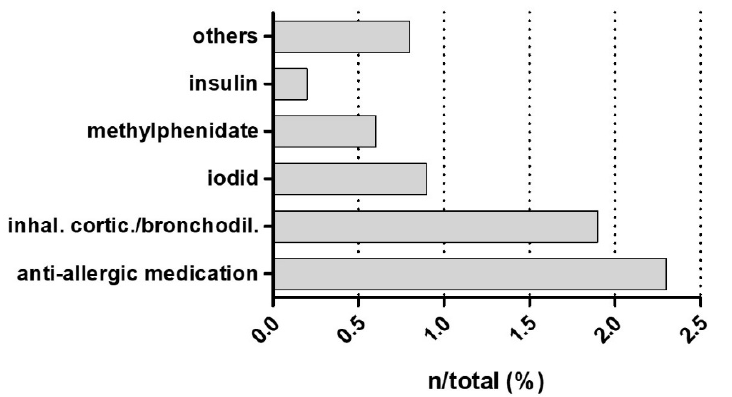
Figure 1. Listing of regular medication, indicated as a percentage of total study population (%).